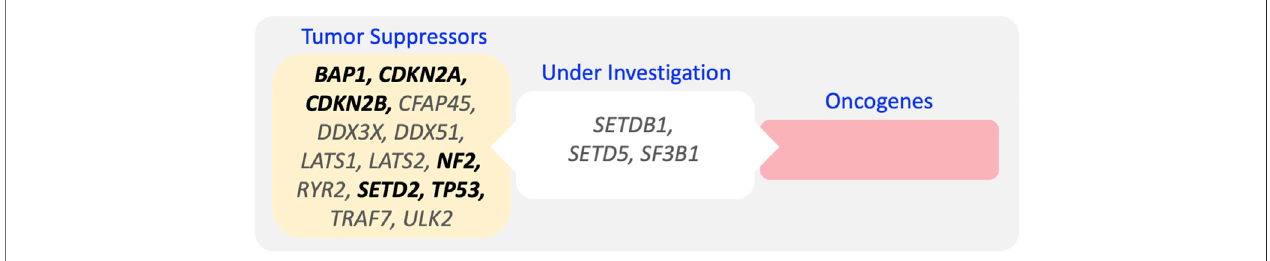
FIGURE 2 | Frequent Mutations in MPM. Genes with validate tumor suppressor function, and not-classi fi ed genes are indicated (genes found with a mutation frequency > 5% are indicated in